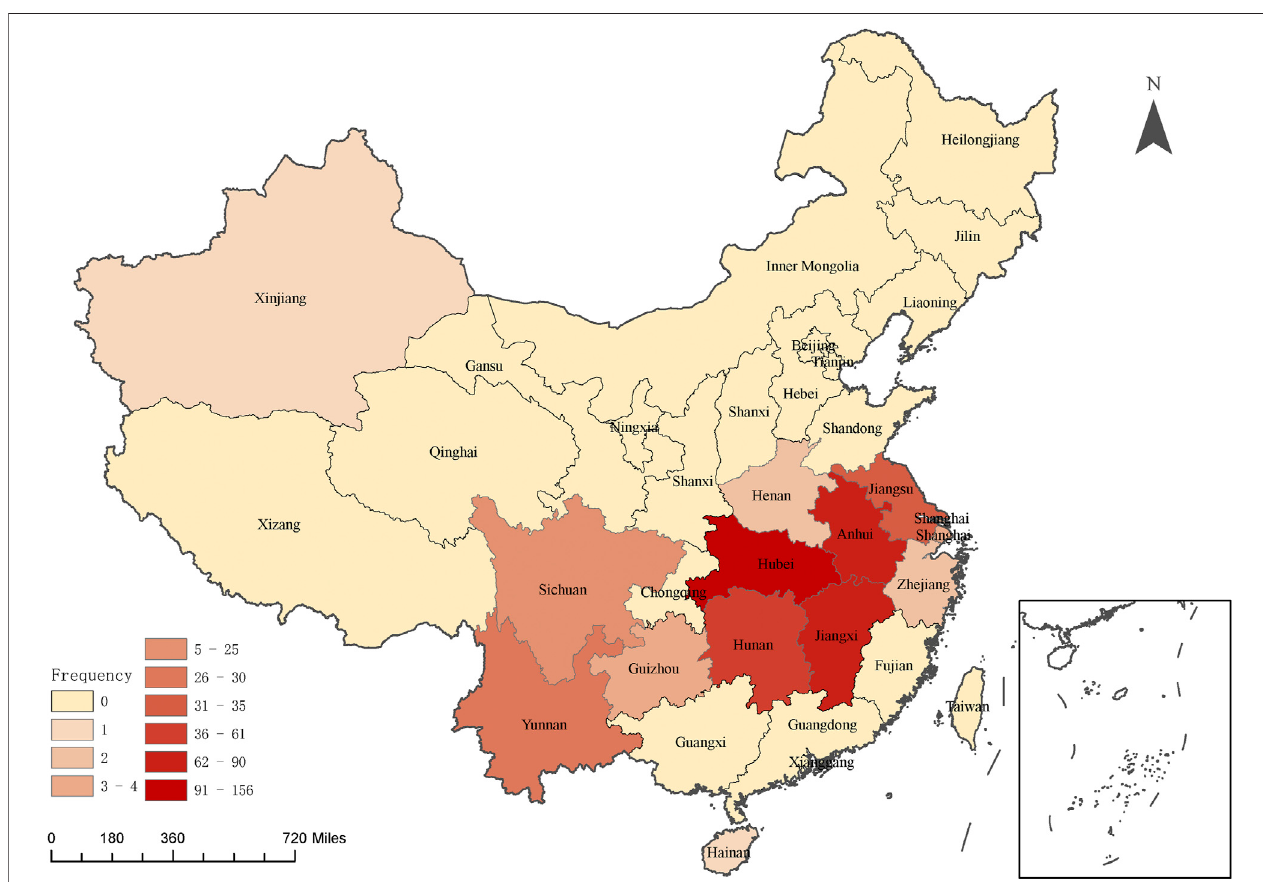
FIGURE 2 | Map of China with the number of eligible studies with extractable data by province.